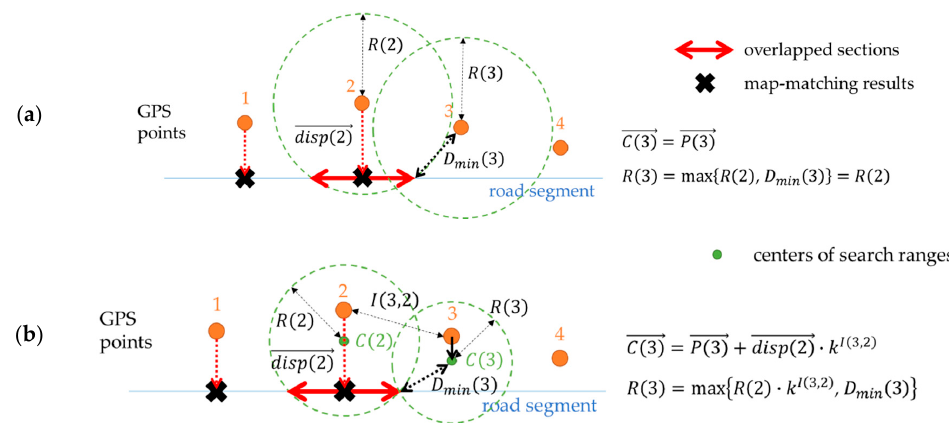
Figure 8. Determining search radius with adaptation when the positional error decreases ( D ( i ) < R ( i − 1 )) : ( a ) Assuming no adaptation (the basic method in Section 4.1.), R ( i ) = R ( i − 1 ) min −−→ −−→ C ( i ) = P ( i ) , same as the Figure 6; ( b ) Assuming adaptation with a certain coefficient (0 ≤ k ≤ 1), and